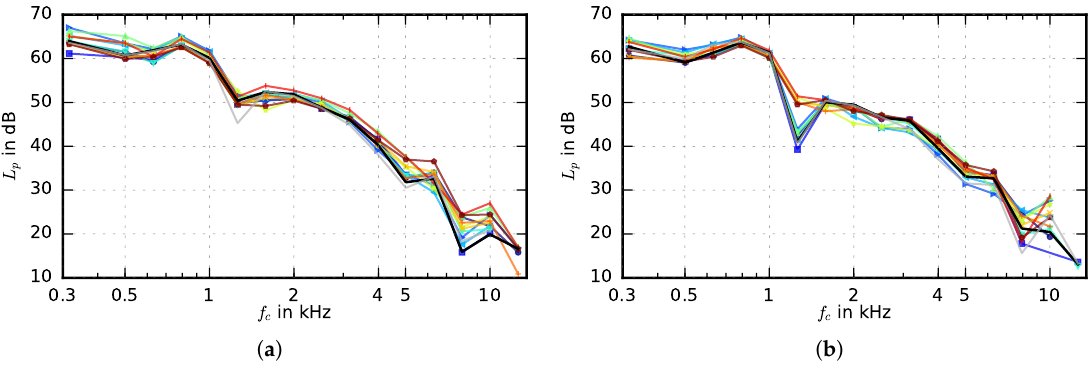
Figure 8. One third octave band sound pressure level spectra at U ≈ 40 m/s and α = 6 ◦ (airfoil 1, 2, 3, 4, 5, 6, 7, 8, 9, 10, 11), ( a ) PPS 12/2 turbulence grid, U = 40.5 m/s, Tu = 4.6%, Λ = 5.0 mm, ( b ) PPS 14/4 turbulence grid, U = 38.7 m/s, Tu = 5.0%, Λ = 5.8